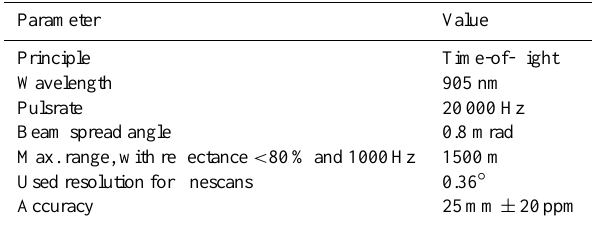
Table 1. Technical features of the used long range laser measuring systems (LPM-321; Riegl,